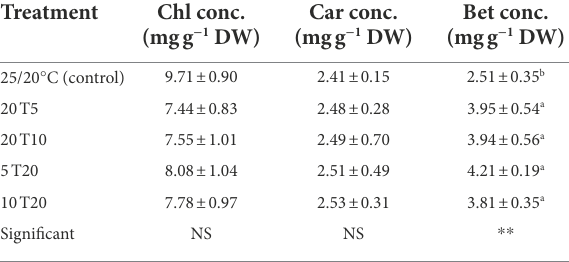
TABLE 4 Total chlorophyll (Chl conc.), carotenoid (Car conc.), and betalain (Bet conc.) concentrations in leaves of amaranth seedlings after treatment with different short-term root-zone temperatures (RZT) for 3 days (Experiment 2). Treatment